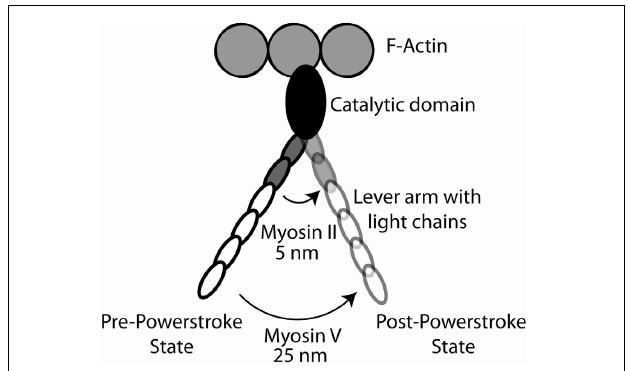
FIGURE 7 | Cartoon of the myosin cross-bridge powerstroke. The effect of lever arm length on the effective powerstroke is shown for myosin II (two bound light chains) and myosin V (six bound light chains). The position of the lever arms in the pre-powerstroke and post-powerstroke positions are